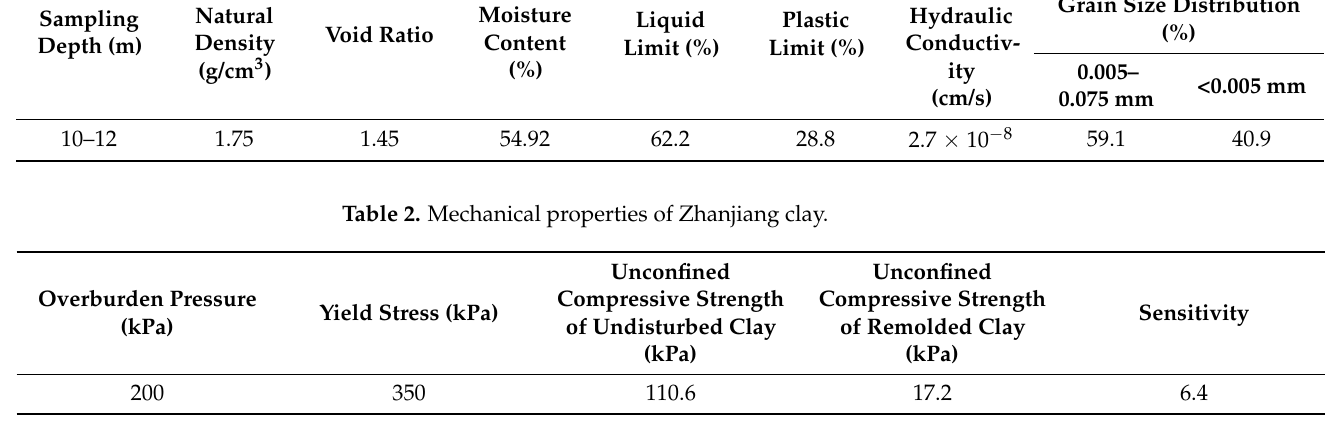
Table 1. Physical properties and grain size distribution of Zhanjiang clay.